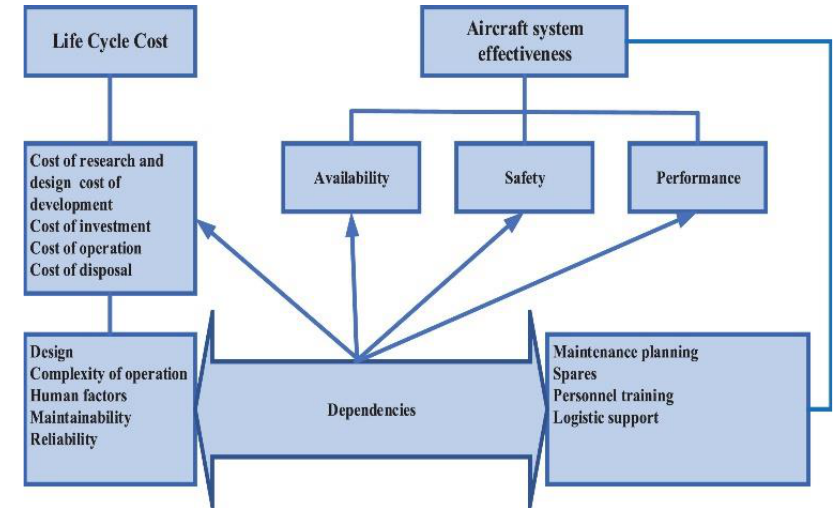
Figure 3: Link between life cycle cost and airplane system effectiveness; Source: (Mofokeng et. al.,